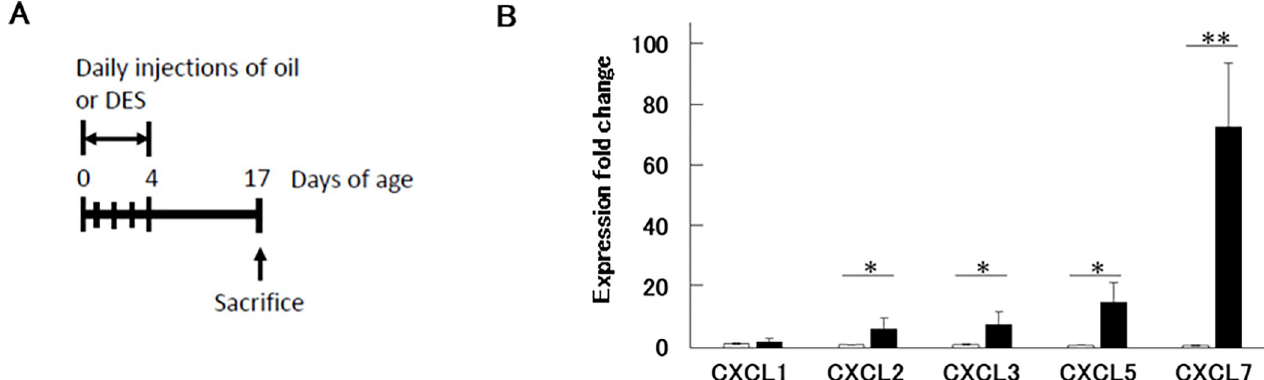
Fig 3. DES-induced expression changes of CXC chemokine genes in day-17 mice vagina. (A) The procedures are illustrated. (B) Total RNA was extracted from the whole vagina and subjected to qPCR analysis. Expression fold change between day-17 neoOil (gray) or neoDES (black) was shown. Genes indicated were analyzed (n = 3; t-test, � p < 0.05, �� p < 0.01).